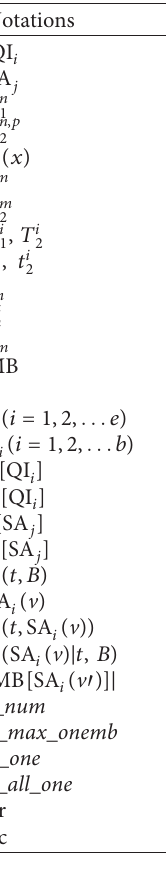
Table 1: Summary of